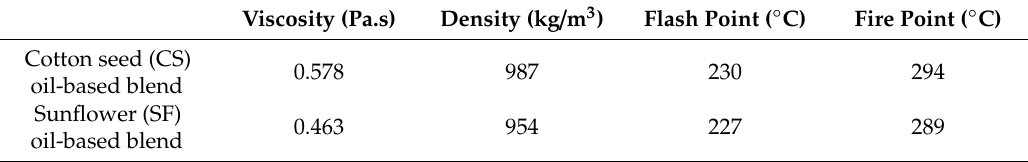
Table 2. Physical properties of blends prepared for the carrier